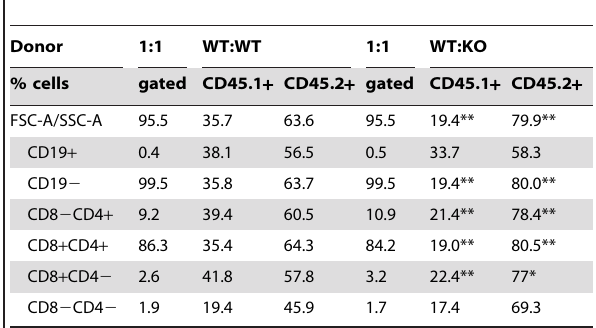
Table 5. FACS analysis of the B cell populations present in the lymph nodes three months after competitive bone marrow transplantation.